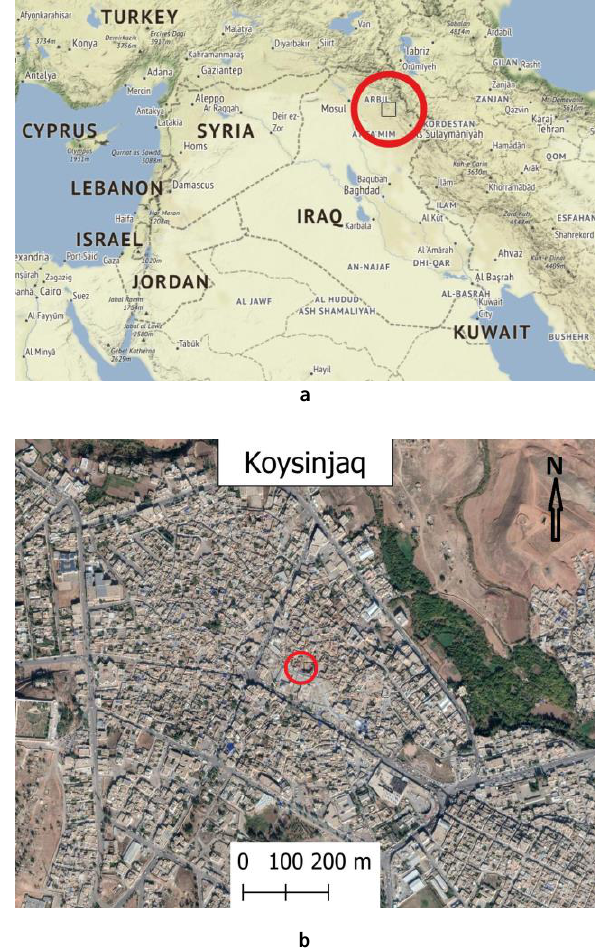
Figure 1 a, b. Location of the study area: Iraqi Kurdistan, city of Koysinjaq. Credits: stemen and Google